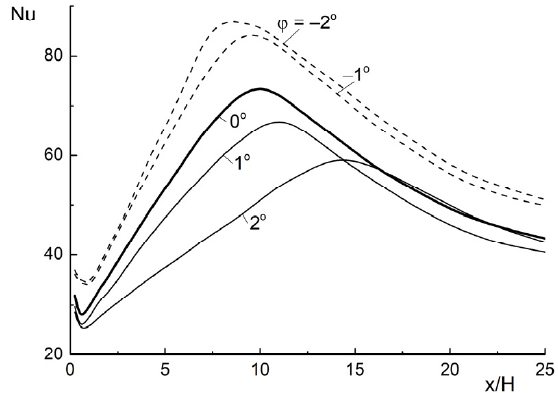
Figure 7. Nusslet numbers distributions along streamwise coordinate in ZPG ( φ = 0°), FPG ( φ < 0°), and APG ( φ > 0°). M L 1 = 0.05, d 1 = 30 μ m.